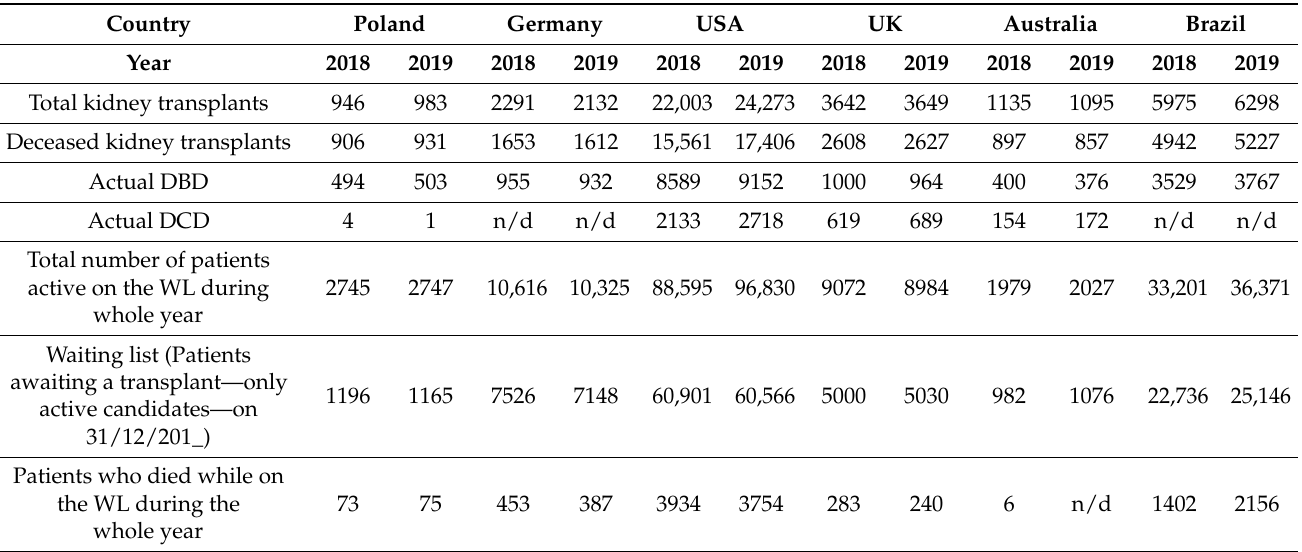
Table 1. Kidney transplant and waiting patient statistics for 2018 and 2019 [13]. Those 2018 and 2019 data are based on the Global Observatory on Donation and Transplantation (GODT) data, produced by the WHO-ONT collaboration. Legend: DCD—donors after circulatory death; DBD—donors after brain death; WL—waiting